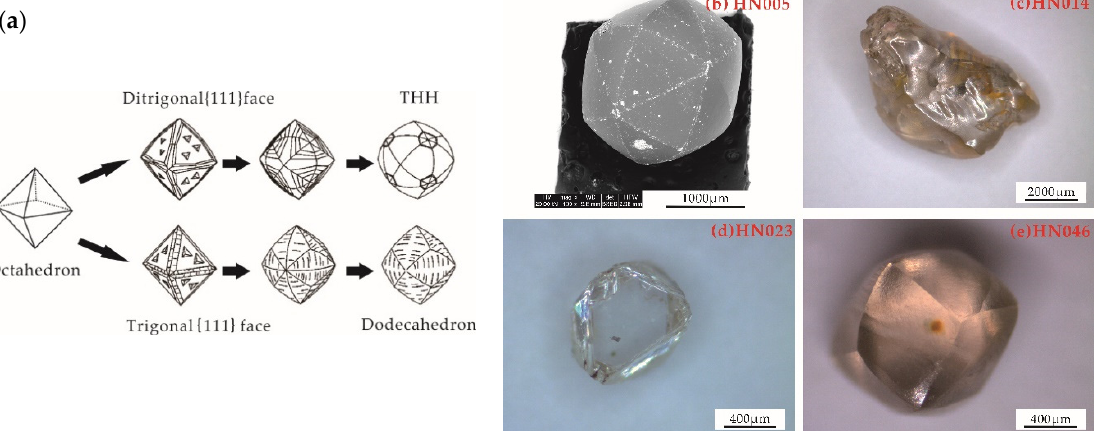
Figure 2. ( a ) Evolution of diamond crystal morphology due to resorption from octahedron to tetrahexahedron (THH) or dodecahedron forms via development of ditrigonal or trigonal shape of {111} faces, respectively (modified after [26,27]); The photographs ( b )-( e ) showing classical crystal forms of the alluvial diamonds from the Yangtze Craton: ( b ) Tetrahexahedra (THH); ( c ) Irregular form; ( d ) Octahedra; ( e ) Dodecahedra.